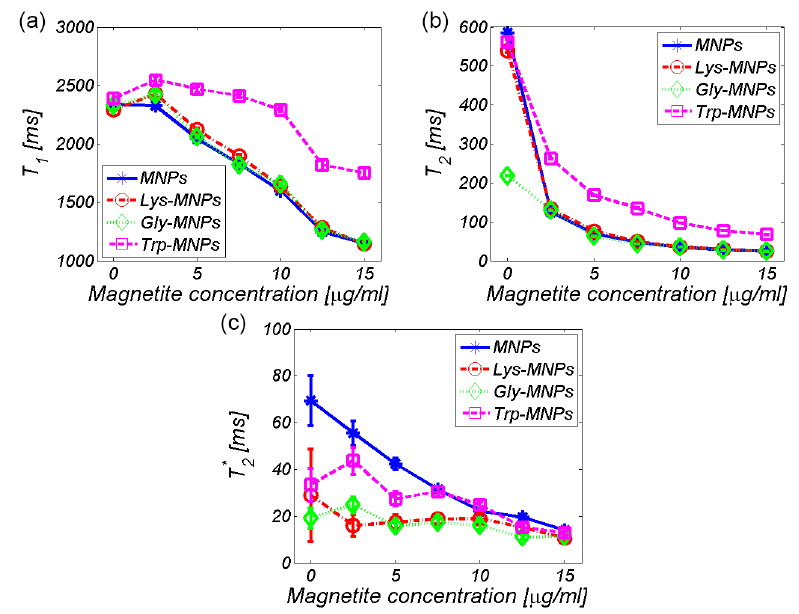
Figure 10. Relaxation time of the AA–MNP complexes depending on the IONP/Fe concentration ( a ) T 1 , ( b ) T 2 , and ( c ) T 2* .